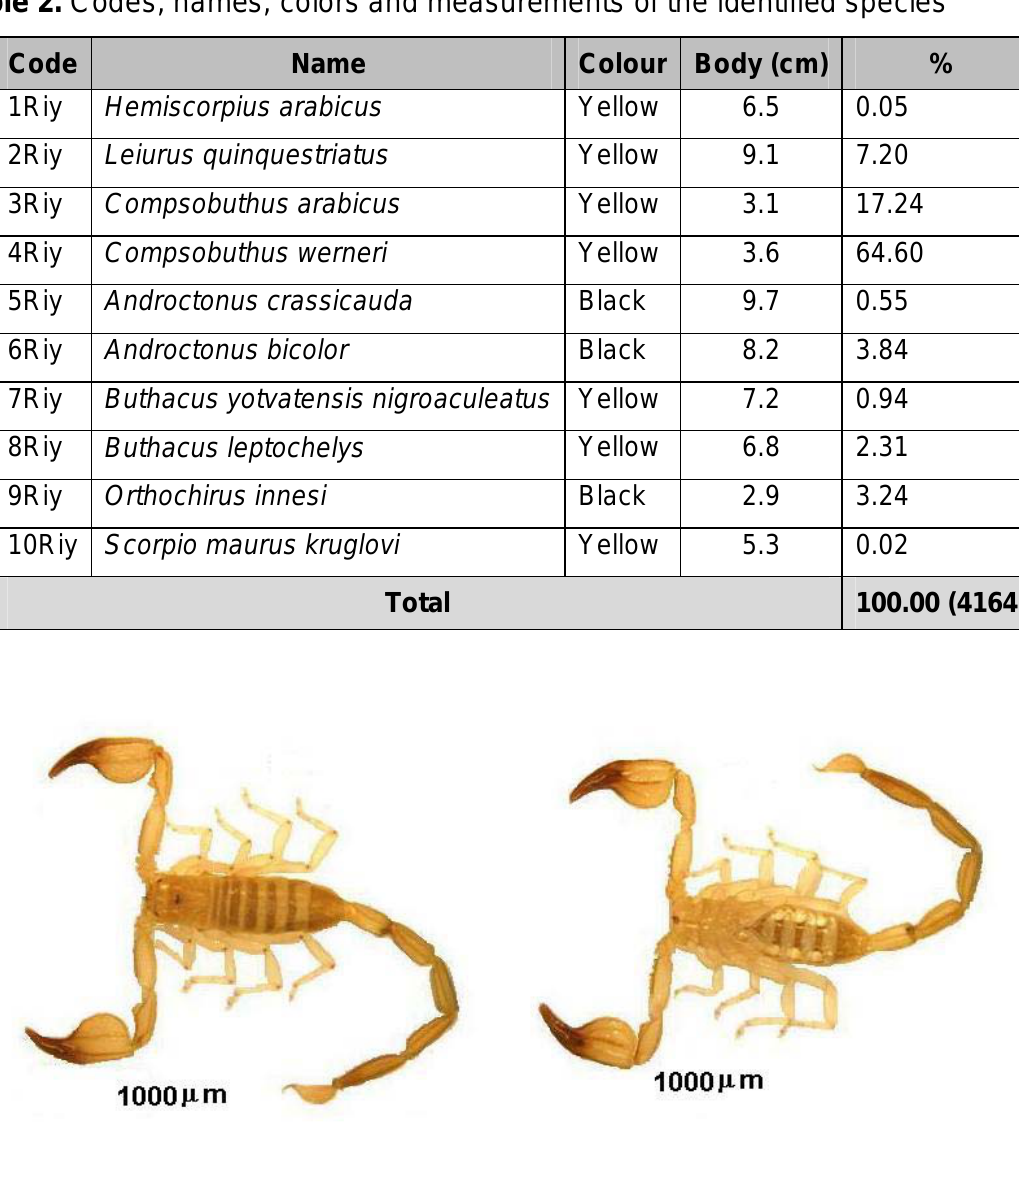
Figure 2. Hemiscorpius arabicus collected in the Riyadh region.